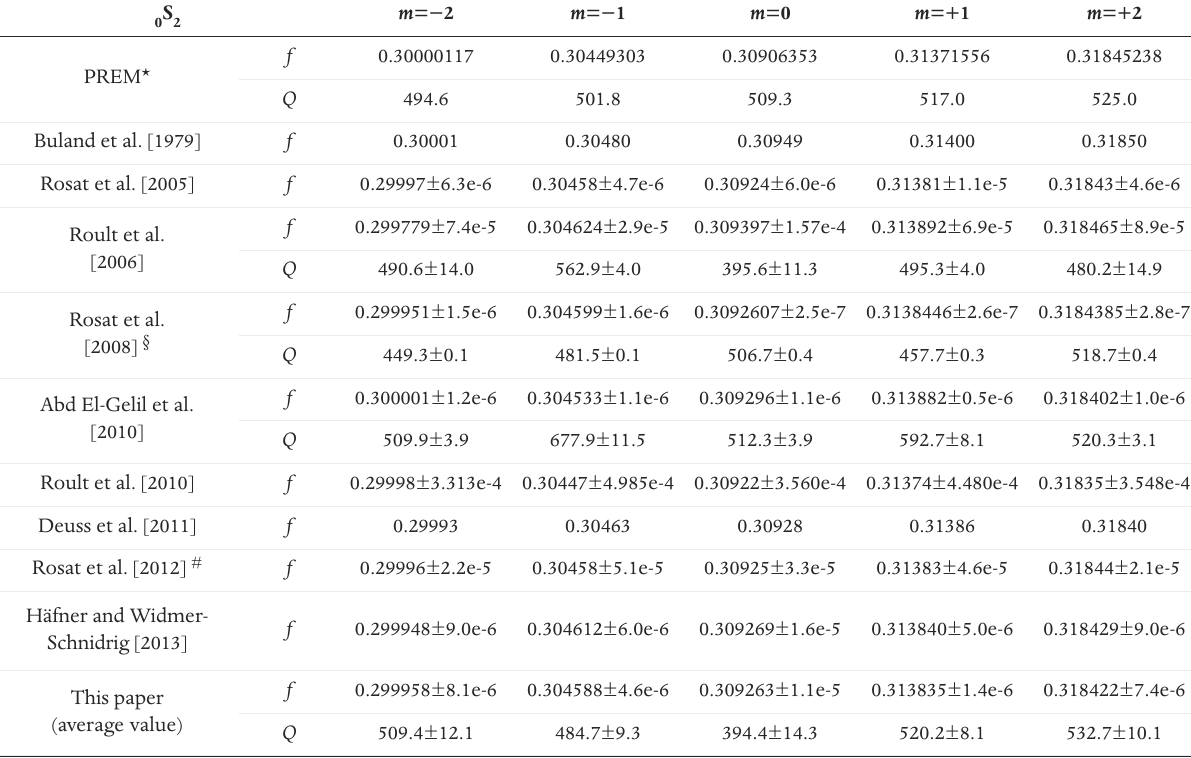
S , compared with the previous estimates and the PREM pre- 0 2